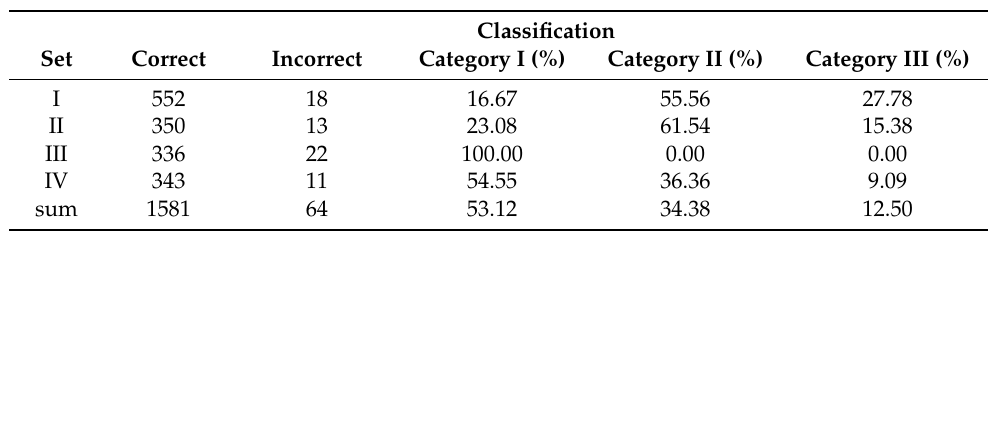
Table 9. Incompletely- or incorrectly-classified support structures according to type of